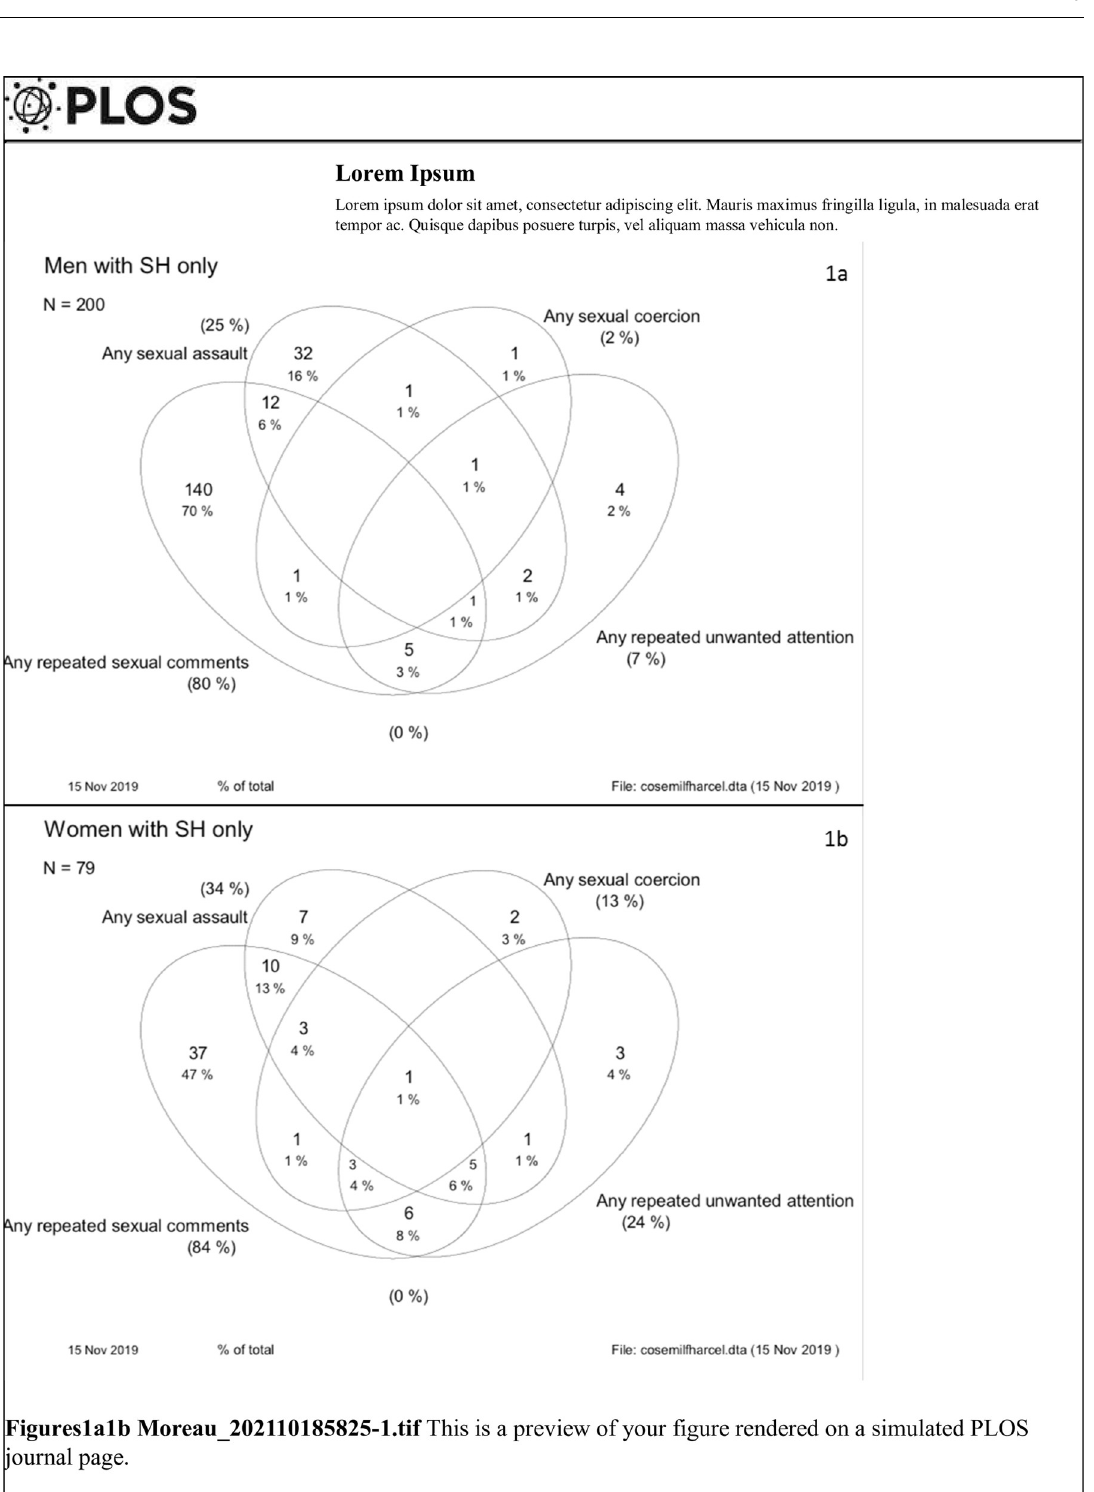
Fig 1. a, b: Distribution of type of sexual stressors experiences among service men and service women who report any MST event.